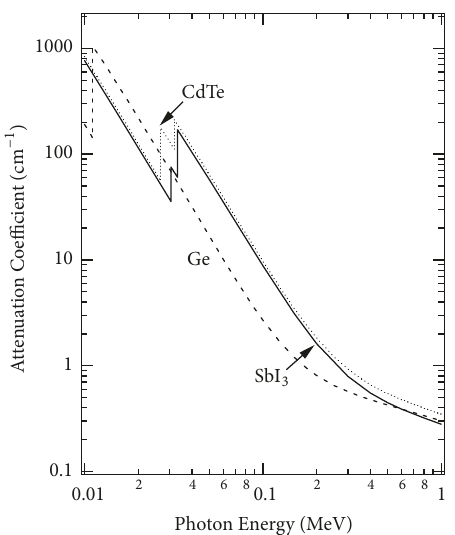
Figure 1: Attenuation coefficients of semiconductor detector materials as functions of the photon energy.